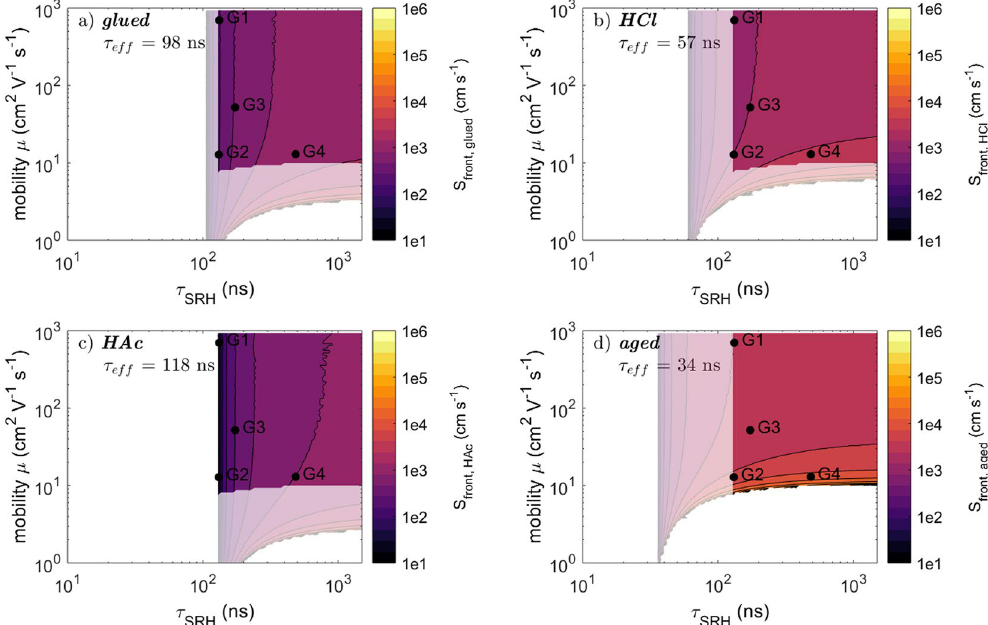
Figure 6. Solutions of the parameters for τ bulk and μ and the surface recombination velocities for the bg-CIGS absorber based on Eqn. (14). The pale areas indicate the solution when taking into account only one decay time for the corresponding sample configuration. Bright areas indicate solutions considering the solutions for all